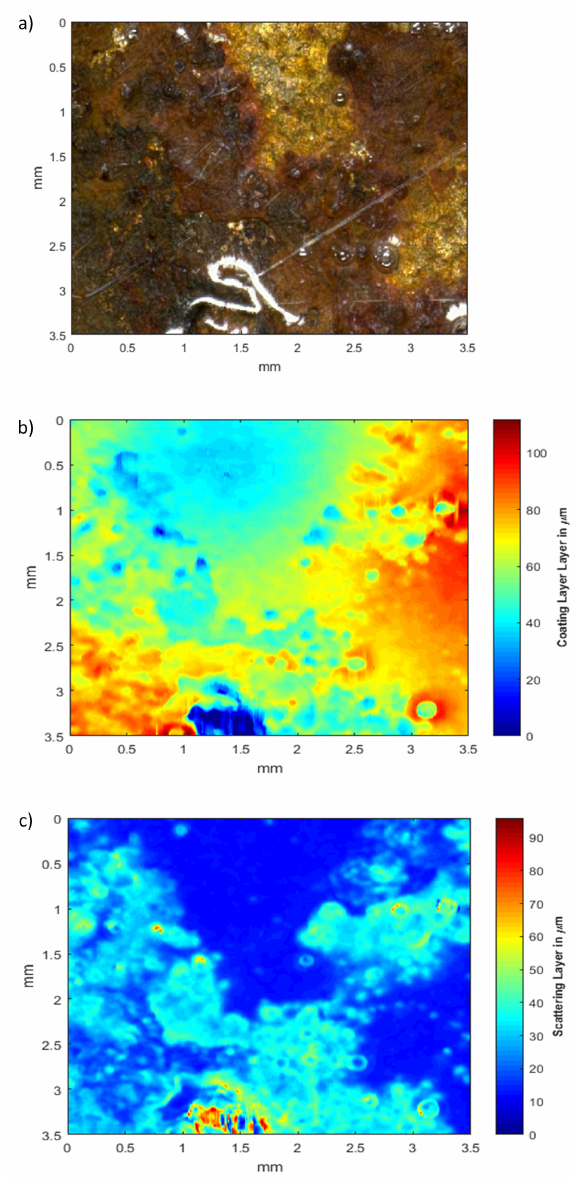
Figure 8. ( a ) Microscopy image of a standard sample (sample 8); ( b ) heat map of the calculated layer thickness for the OCT measurement; ( c ) heat map of the calculated scattering layer thickness for the OCT